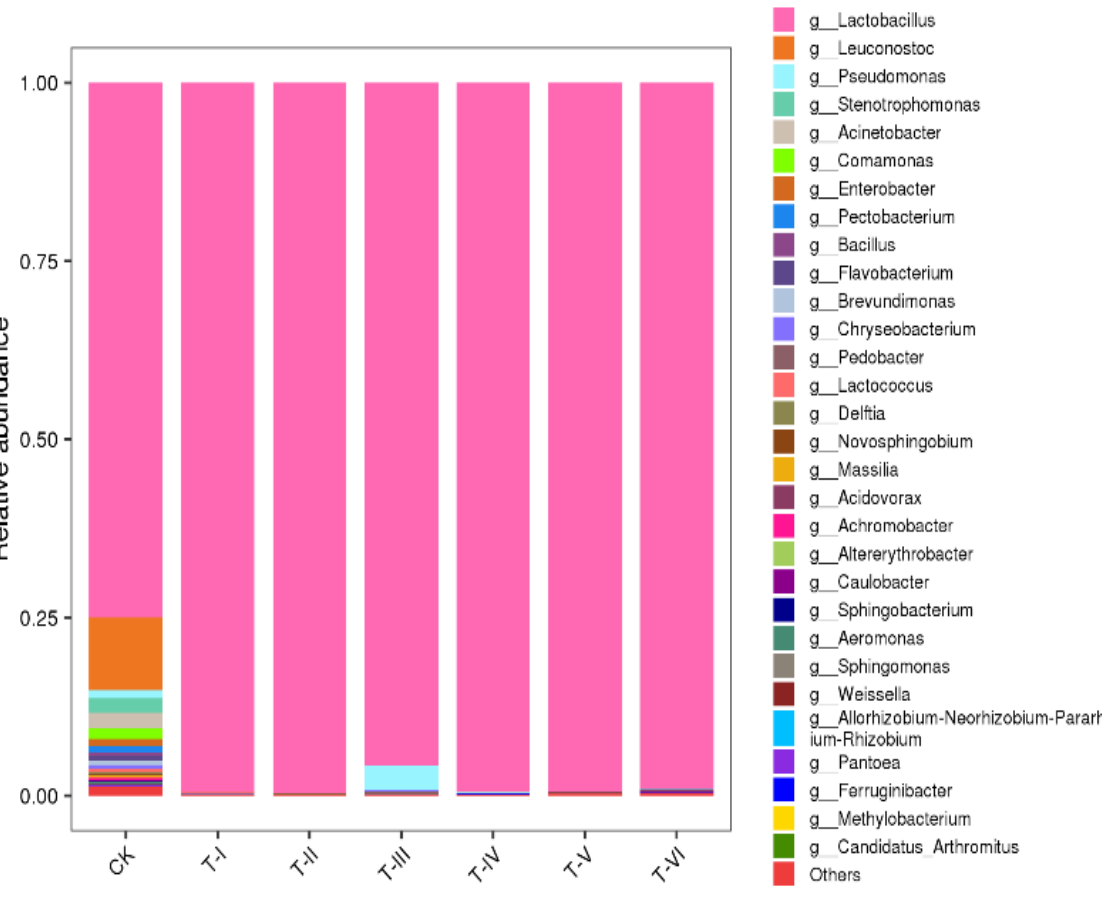
Figure 1. Relative abundance of bacterial genera in different soup samples (Sample codes indicate the samples fermented for 0 d (CK), 5 d (T-I), 10 d (T-II), 15 d (T-III), 20 d (T-IV), 25 d (T-V), and 30 d (T-VI)).